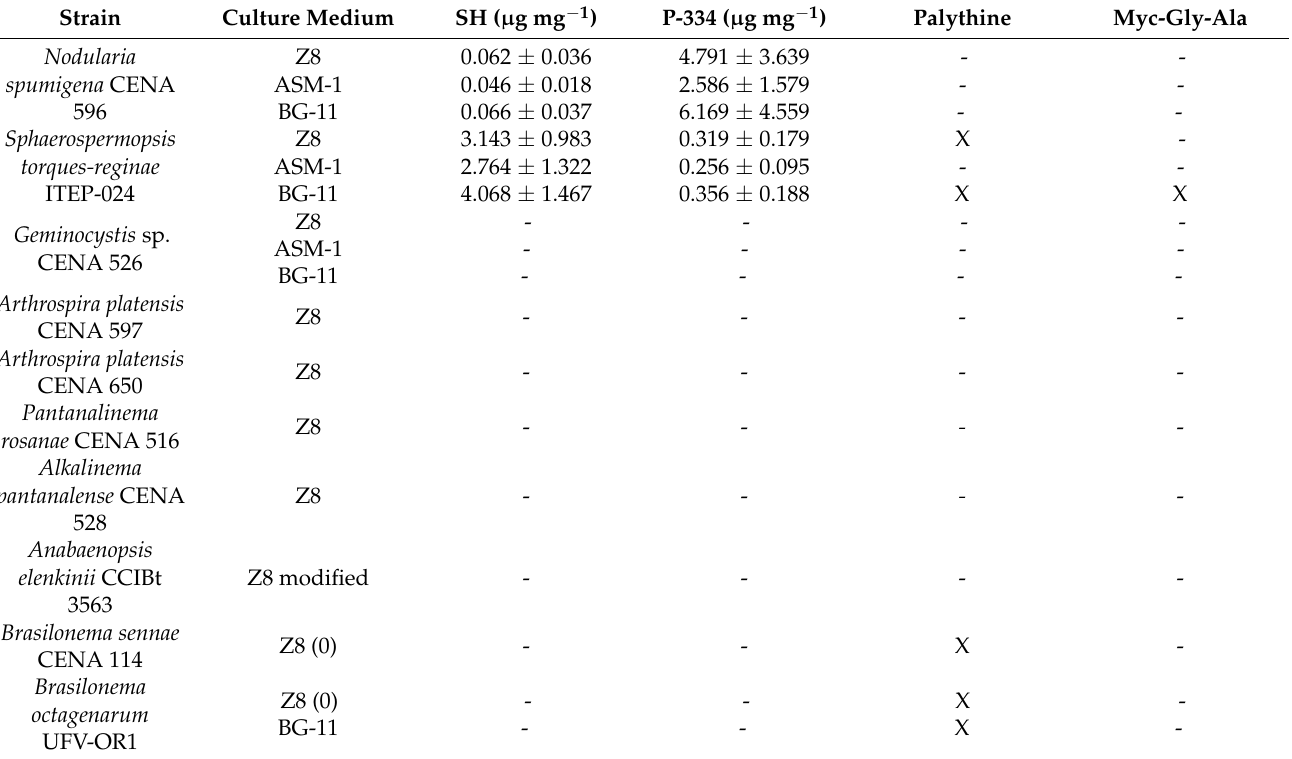
Table 1. Concentration of shinorine (SH) and porphyra-334 (P-334) detected in cyanobacteria strains according to the culture medium.